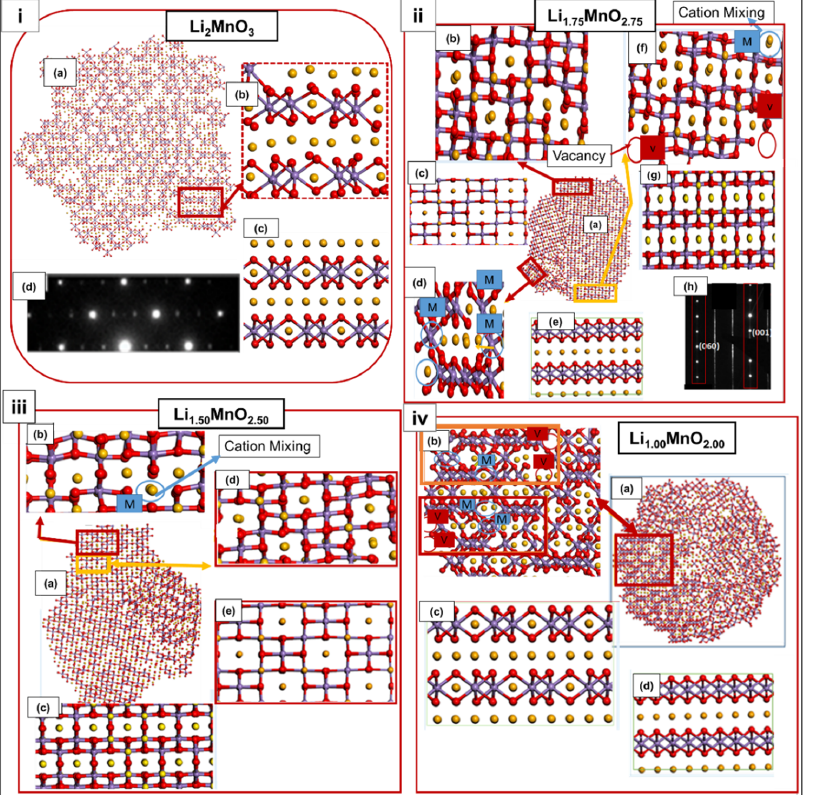
Figure 4. [ i ] ( a ) Cut-through Li 2 MnO 3 , ( b ) magnified portion from ( a ) depicting the Li 2 MnO 3 component, ( c ) Li 2 MnO 3 perfect model and ( d ) Li 2 MnO 3 SAED experimental patterns reproduced with permission from Ref. [5]. 2017. Advanced Materials Interfaces. [ ii ] ( a ) Cut-through Li 1.75 MnO 2.75 , ( b ) magnified segment from ( a ) illustrating the distorted spinel LiMn 2 O 4 phase, ( c ) LiMn 2 O 4 perfect ( e ) the LiMnO 2 perfect model, ( f ) magnified portion from ( a ) revealing the Li 2 MnO 3 component, ( g ) perfect Li 2 MnO 3 model, and ( h ) Li 2 MnO 3 SAED reproduced with permission from Ref. [26]. 2015. Nano Energy. [ iii ] ( a ) Cut-through Li 1.50 MnO 2.50 , revealing ( b ) Li 2 MnO 3 component, ( c ) Li 2 MnO 3 ( e ) the LiMn 2 O 4 perfect model. [ iv ] ( a ) Cut-through Li 1.00 MnO 2.00 depicting ( b ) magnified portion ( c ) the Li 2 MnO 3 perfect model and ( d ) LiMn 2 O 4 perfect